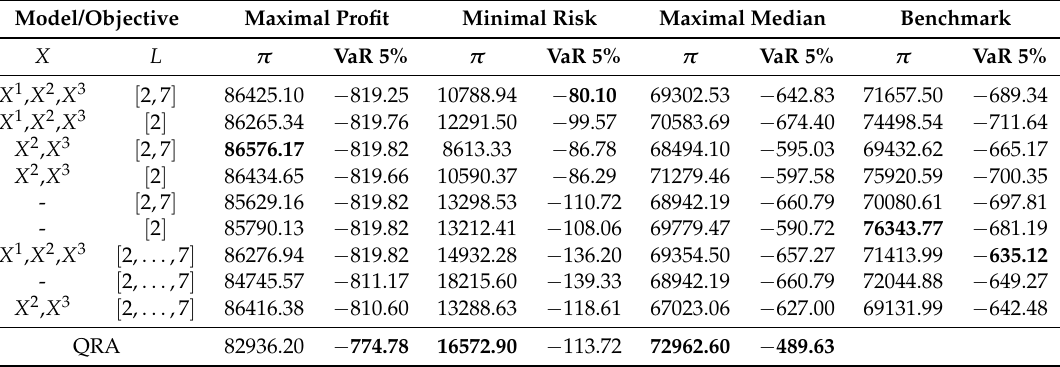
Table 3. Results of the proposed strategies based on the maximization of the 95% quantile